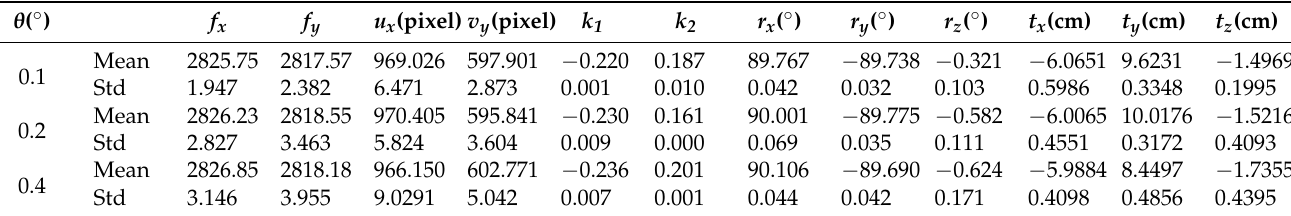
Table 6. Mean and Std of optimization parameters.